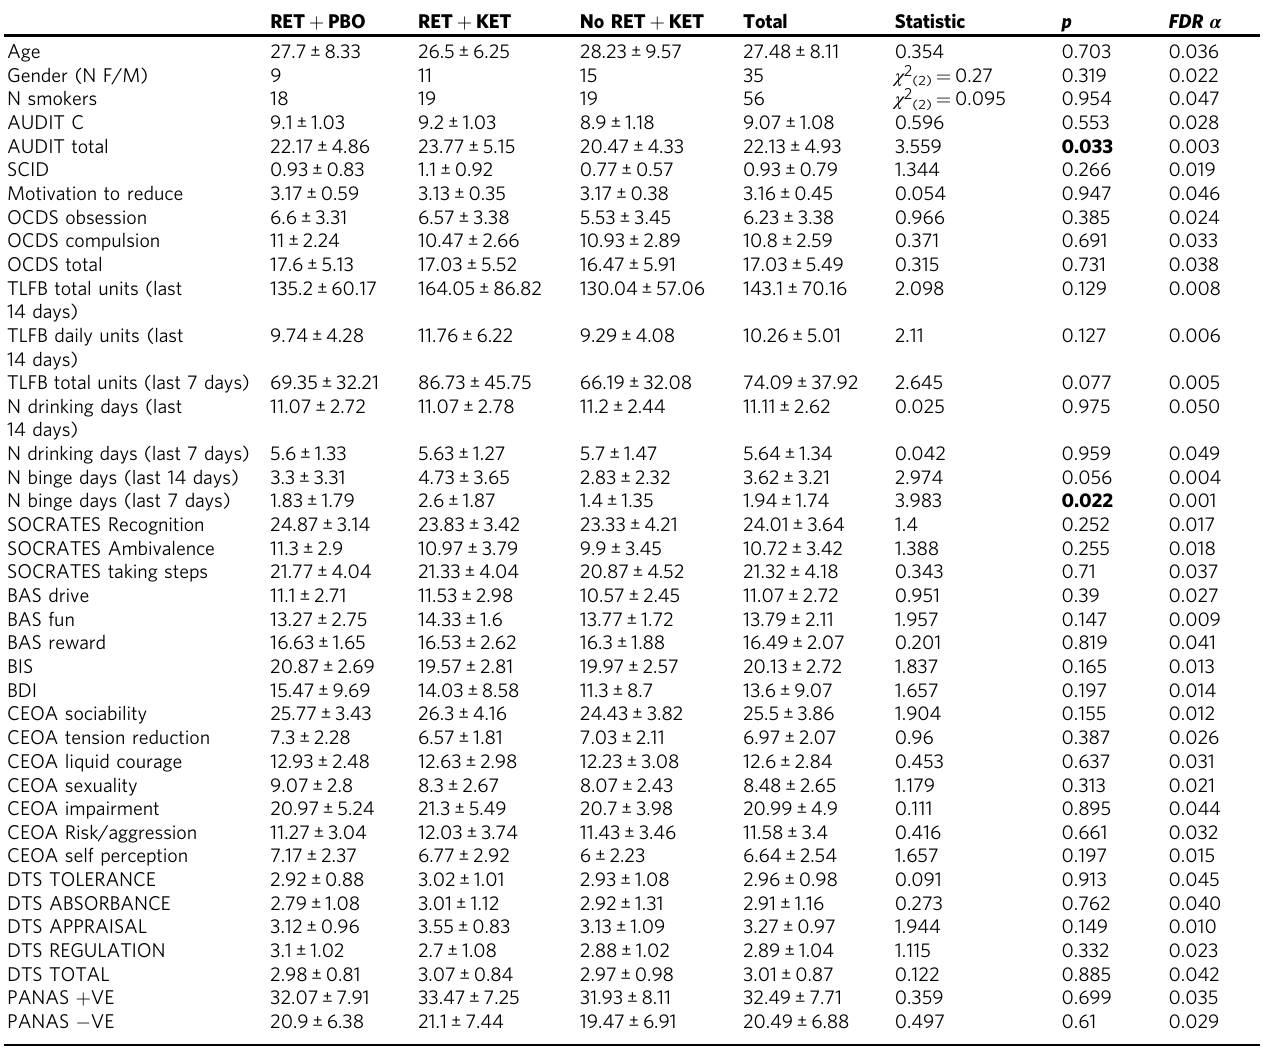
For continuous measures, the statistics given are mean±SD, along with corresponding F values (DF 2, 87). For binary measures, Ns are given along with chi-square degrees of freedom and test values (denotedby χ 2 ). “ RET ” = Retrieval, “ KET ” = Ketamine, “ PBO ” = Placebo.FDR α = FalseDiscoveryRatealpha,calculatedaccordingtoBenjaminiandHochberg 36 . P -valuesrepresentOne-wayANOVAon group differences. Signi fi cant uncorrected p -values at p <0.05 are highlighted in bold. Only p -values lower than the associated FDR α are signi fi cant at FDR- corrected p <0.05. The groups did not differ on any baseline variables according to FDR